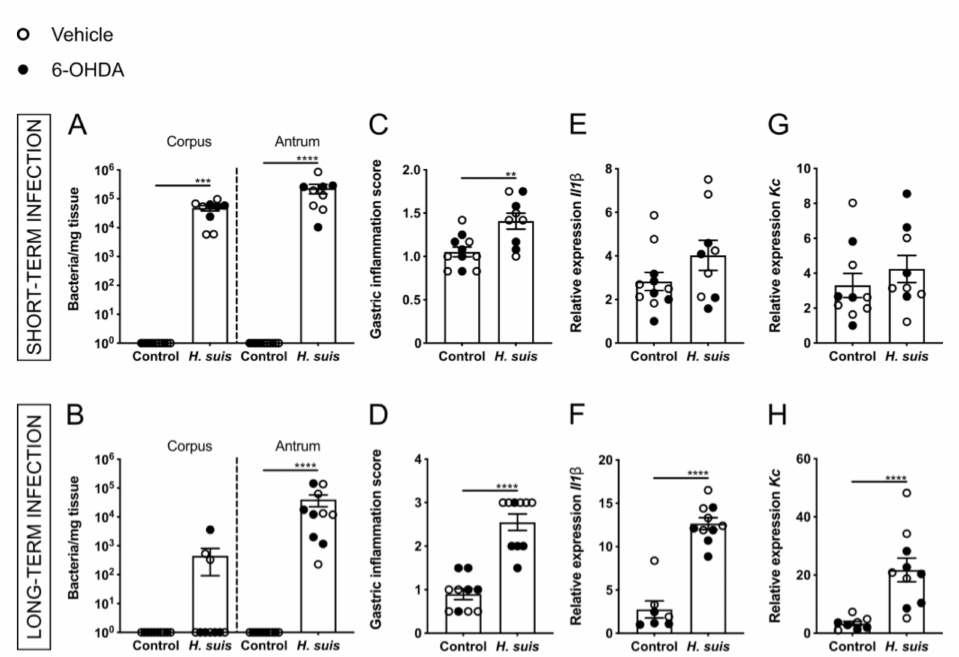
Figure 2. Both short- and long-term gastric Helicobacter suis ( H. suis ) infection is associated with gastric colonization and inflammation. ( A , B ) H. suis colonization in the stomach (corpus and antrum) of mice infected with H. suis or the control broth for a short- (n = 9–11) ( A ) and long-term period (n = 10) ( B ), 7 days after instrastriatal injection with either 6-OHDA (black) or vehicle (white). ( C , D ) Gastric inflammation score according to the Updated Sydney System based on haematoxylin and eosin (H&E) staining of the stomach of control and H. suis -infected mice for short- (n = 9–11) ( C ) and long-term infection (n = 10) ( D ). ( E – H ) Relative mRNA gene expression of the cytokine interleukin 1 β ( Il1 β ) and the chemokine keratinocyte chemoattractant ( Kc ) in the corpus of the stomach after short- (n = 9–11) ( E ) and long-term infection (n= 7–10) ( F ). Data were analyzed by the Mann–Whitney test. ** 0.001 ≤ p < 0.01; *** 0.0001 ≤ p < 0.001; **** p <